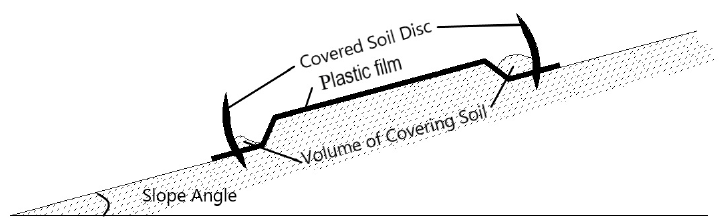
Figure 3. The soil covering at the sloping field.